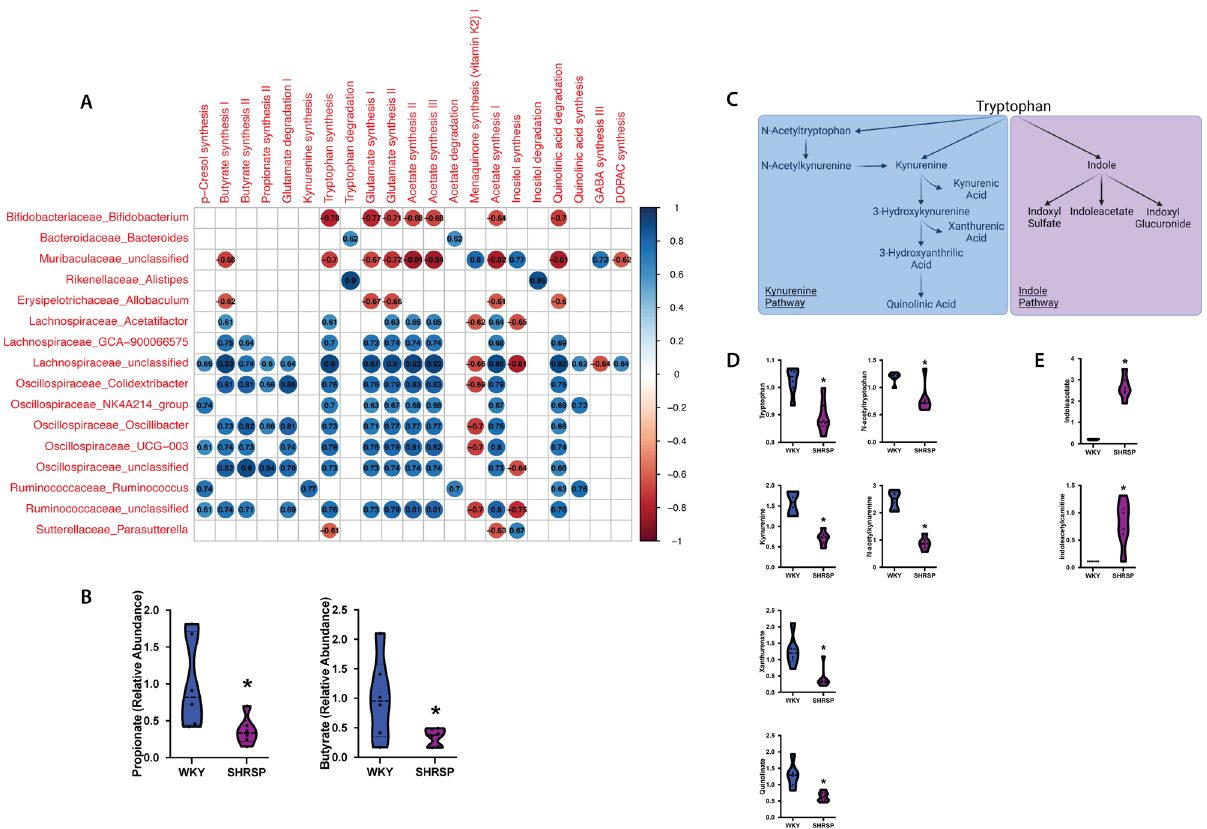
Figure 6. ( A ) Heatmap of Spearman correlations between gut-brain modules (GBM) and genera relative abundance. Genus-GBM pairs with correlations > = 0.6 or < = −0.6 and p -value < 0.05 are shown. ( B ) Short- chain fatty acid measurement of WKY and SHRSP plasma. ( C ) Schematic diagram of tryptophan metabolism pathways. D-E. WKY and SHRSP plasma metabolites of kynurenine pathway ( D ) and indole pathway ( E ). (n = 6) * p < 0.05 using Mann–Whitney U test with FDR corrected for multiple